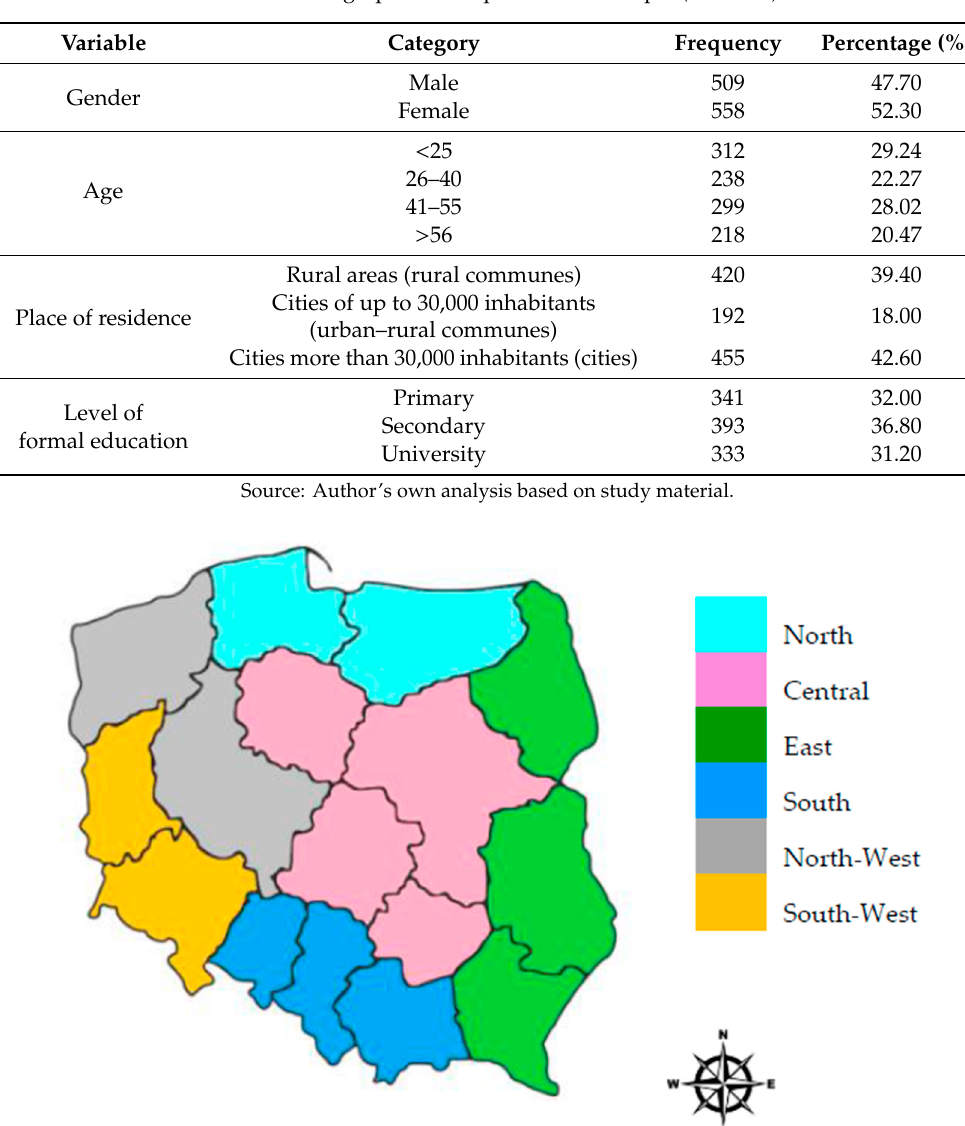
Table 1. Demographic description of the sample ( n = 1067).